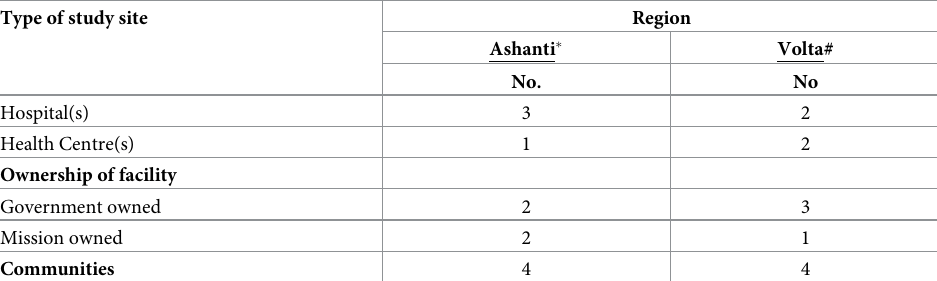
Table 1. Study health facilities and communities in the Ashanti and Volta Regions with